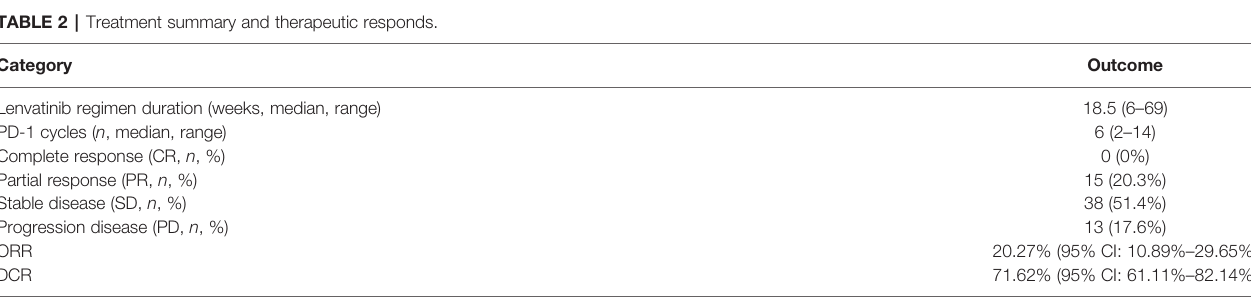
TABLE 2 | Treatment summary and therapeutic responds. Category Outcome Lenvatinib regimen duration (weeks, median,